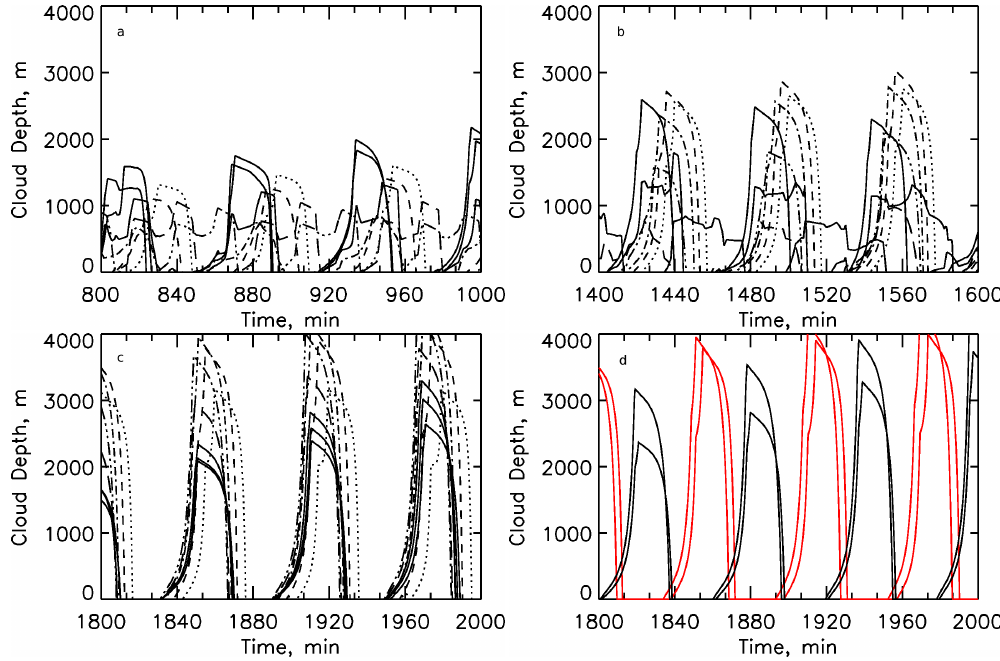
Fig. 4. One-dimensional solution to the equations for I = 21, τ c = 10 . 75min (0 . 5 T ), and η = − 0 . 54 broken into 200min time sections. Fig. 4. One dimensional solution to the equations for I =21, (cid:111) c = 10.75 min (0.5 T ), and (cid:100) = -0.54 broken into 200 min time sections. (a) 800 (a) 800 < t < 1000min, (b) 1400 < t < 1600min, (c) 1800 < t < 2000min. Black lines in (a) , (b) , (c) are for i = 3 , 5 , 7 ,..., 19. Most clouds < t < 1000 min, (b) 1400 < t < 1600 min, (c) 1800 < t < 2000 min. Black lines in (a), (b), (c) are for i = 3, 5, 7,...., 19. Most clouds are out are out of phase with one another but with the passage of time (a–c) all oscillators are entrained to the same phase. (d) 1800 < t < 2000min; of phase with one another but with the passage of time (a – c) all oscillators are entrained to the same phase. (d) 1800 < t < 2000 min; red red lines: i = 5 and i = 7; black lines: i = 10 and i = 12. Adjacent clouds are out of phase. lines: i =5 and i =7; black lines: i =10 and i =12. Adjacent clouds are out of phase.